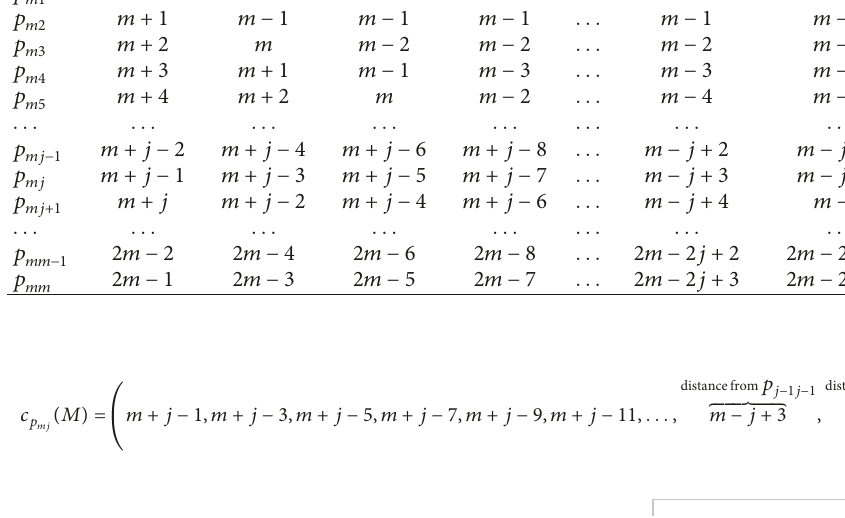
Table 3: Metric codes c